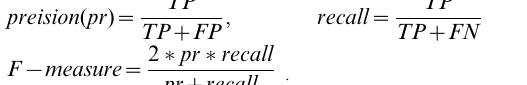
table browser for RefSeq gene sequences of hg19 human genome and same number of non-promoter sequences taken from EID and EMBL database. Non-promoter sequences are combination of sequences from Intron, Exon and 3 9 UTR regions of DNA sequences. Each of these sequences is 1201 bp long. For true